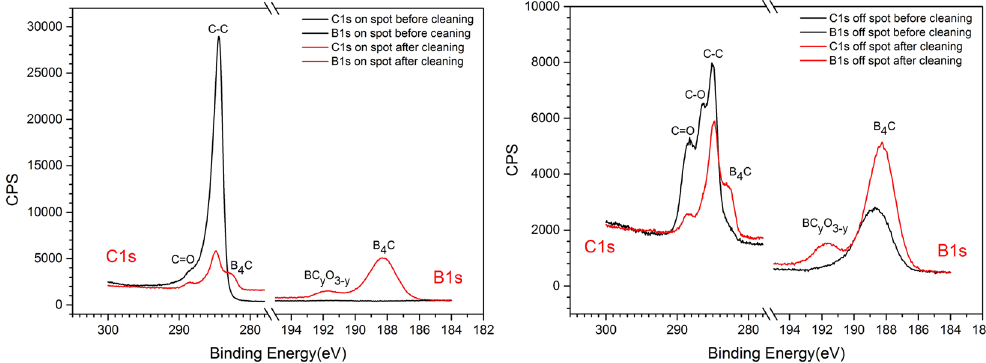
Figure 5. High-resolution C1s and B1s XPS spectra of the B 4 C-coated test wafer before (black solid lines) and after H 2 /Ar RF plasma cleaning (red solid lines). Left panel: XPS data taken on the amorphous carbon contamination spot. Right panel: XPS data taken off the amorphous carbon contamination spot on the bare B 4 C coating.